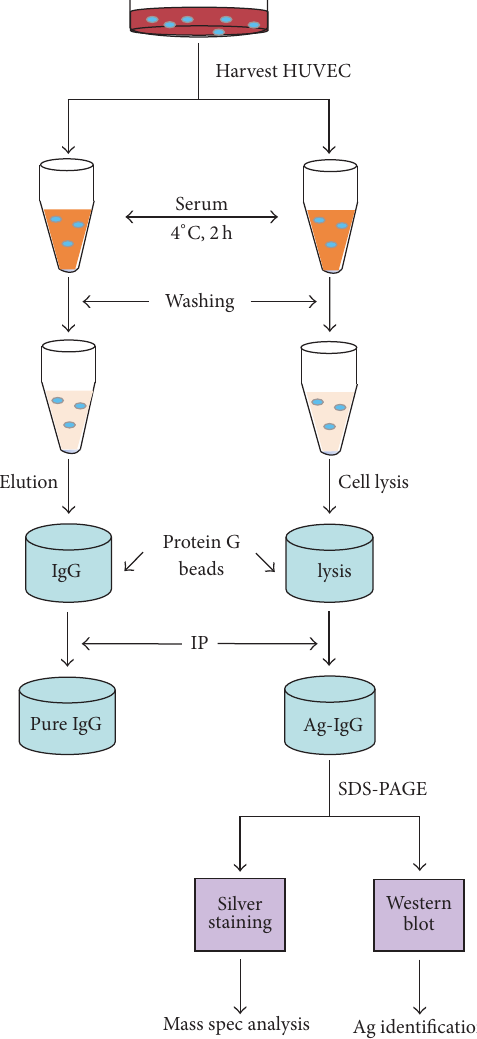
Figure 2: Schematic of procedure used for AECA antibody purifi- cation and antigen